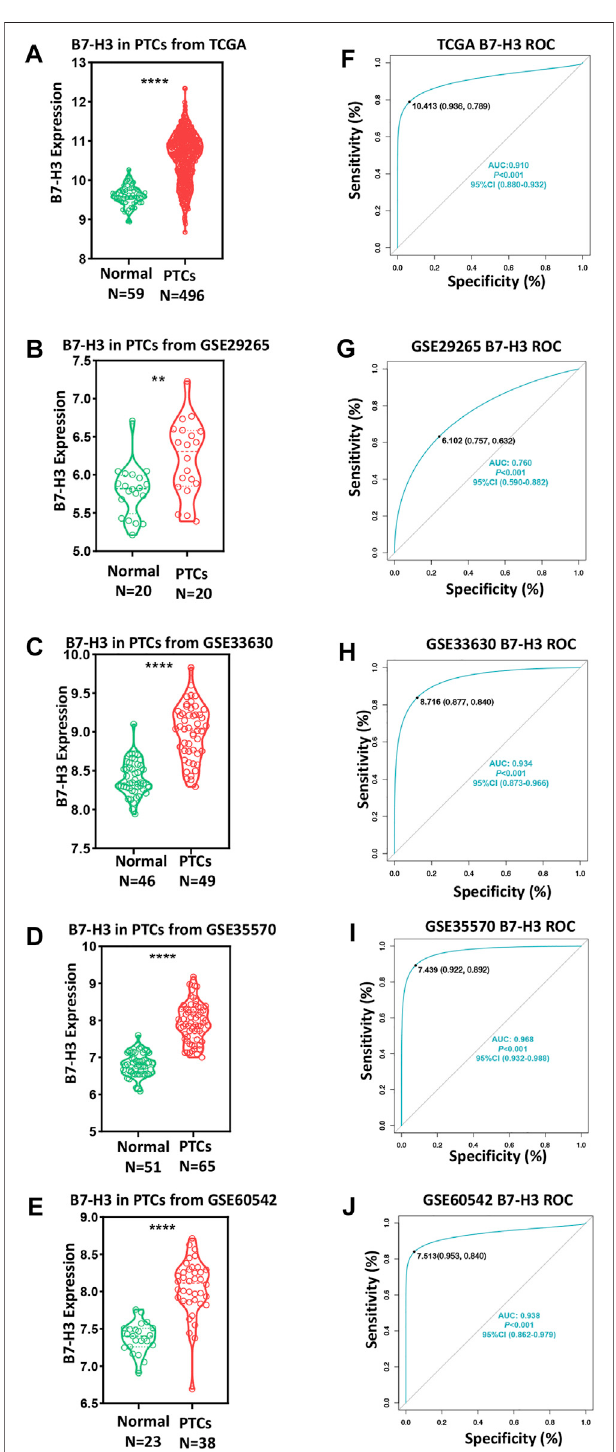
FIGURE 1 | B7-H3 expression of PTC and para-tumor tissue in TCGA and GEO datasets (A – E) . ROC curve of B7-H3 expression in TCGA and GEO datasets (F – J) . ** and **** represent p < 0.01 and p < 0.0001, respectively.